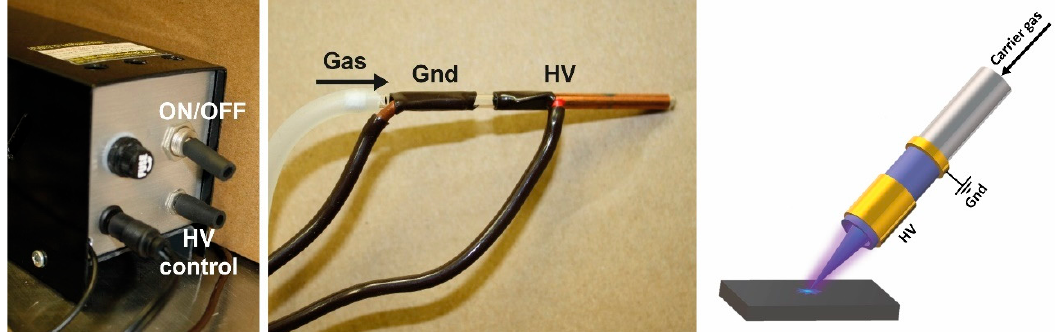
Figure 1. Plasma power source and home-built apparatus ( left ) and schematic description ( right ).